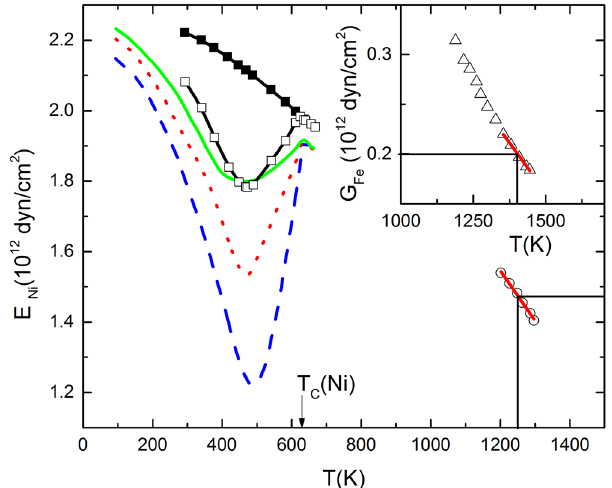
Figure 3. Elastic moduli of Ni and Fe. Dashed, dotted and solid lines show E vs T of Ni samples with grain sizes of 0.037, 0.0105 and 0.0095 mm. Squares show E vs T for a fourth sample in its demagnetized (open squares) and saturated state (solid squares). The arrow marks T Ni ( ) . Circles show E vs T of Ni in the high temperature C regime. The line is a linear best fit to E vs T within ≤ ≤ T 1200 1300 K. Inset shows the T -dependence of the shear modulus of Fe at temperatures above the bcc to fcc transition. The line is a linear best fit to G vs T within ≤ ≤ T 1350 1445 K. All data are adapted from Ledbetter and Reed 38